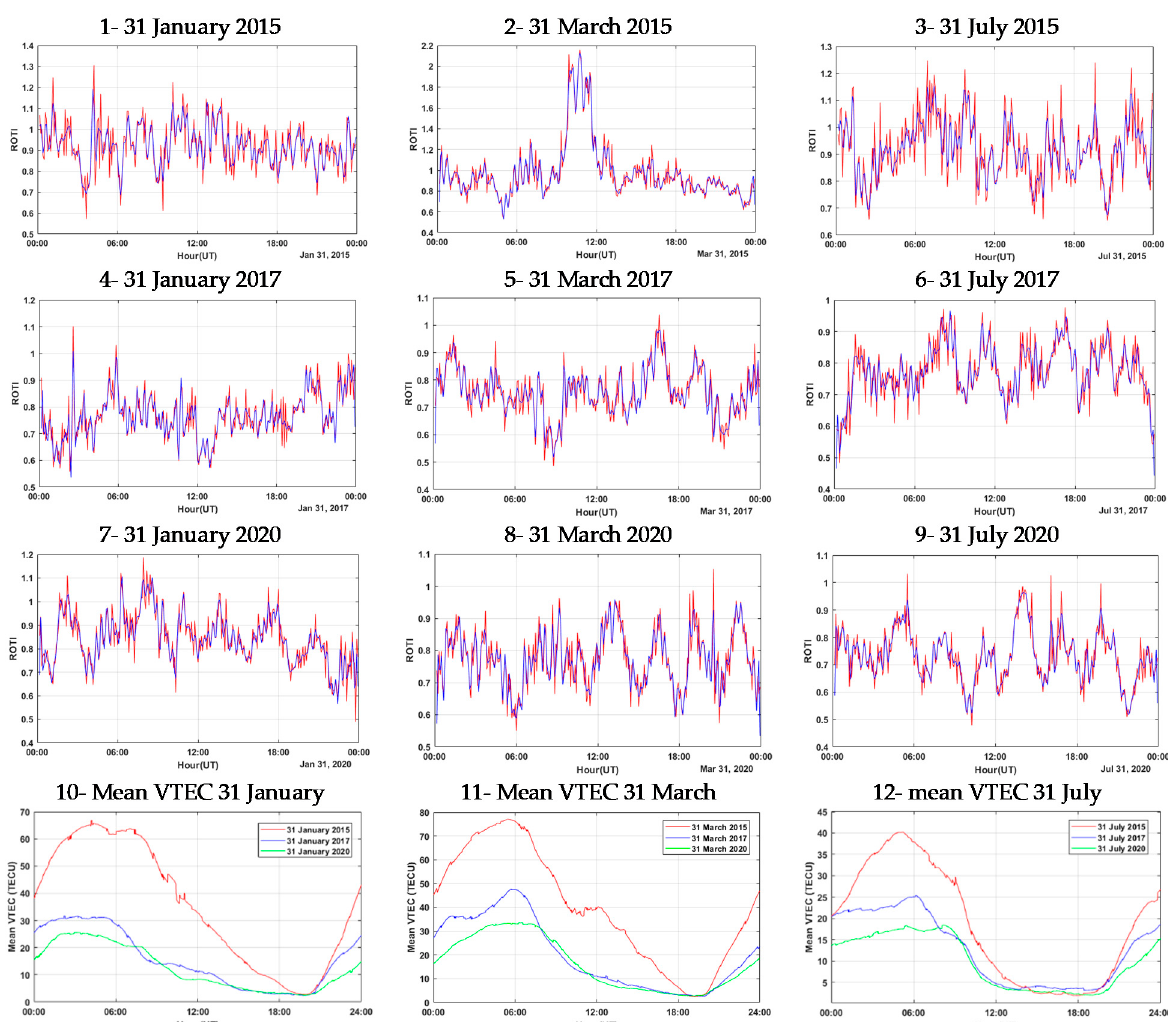
Figure 4. The predicted and observed ROTI during 24 h on 31 January, 31 March, and 31 July in 2015, 2017, and 2020.